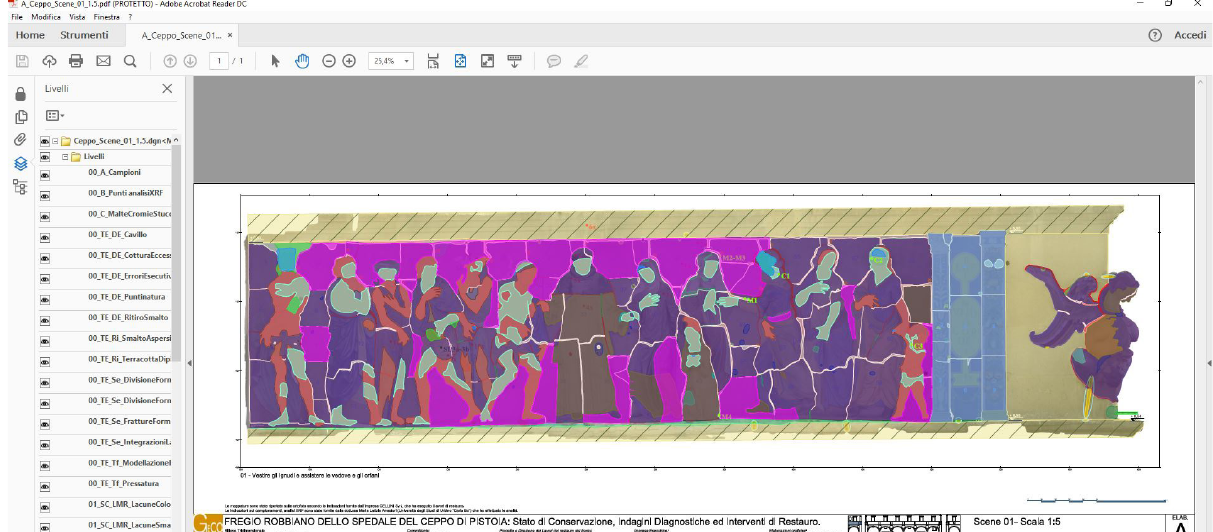
Figure 4. 2D thematic maps related to investigation and conservation work: each theme can be viewed separately or in relation to the